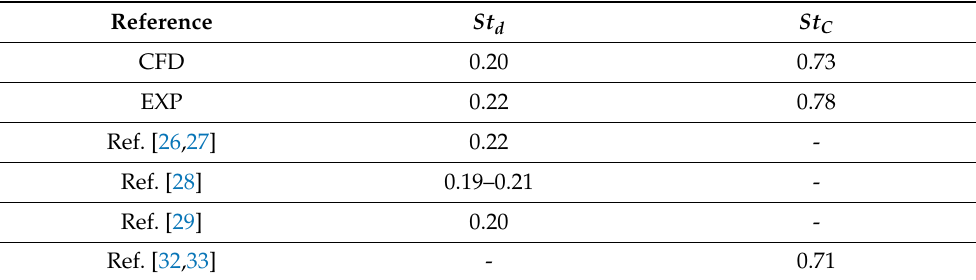
Table 3. Strouhal numbers for vortex